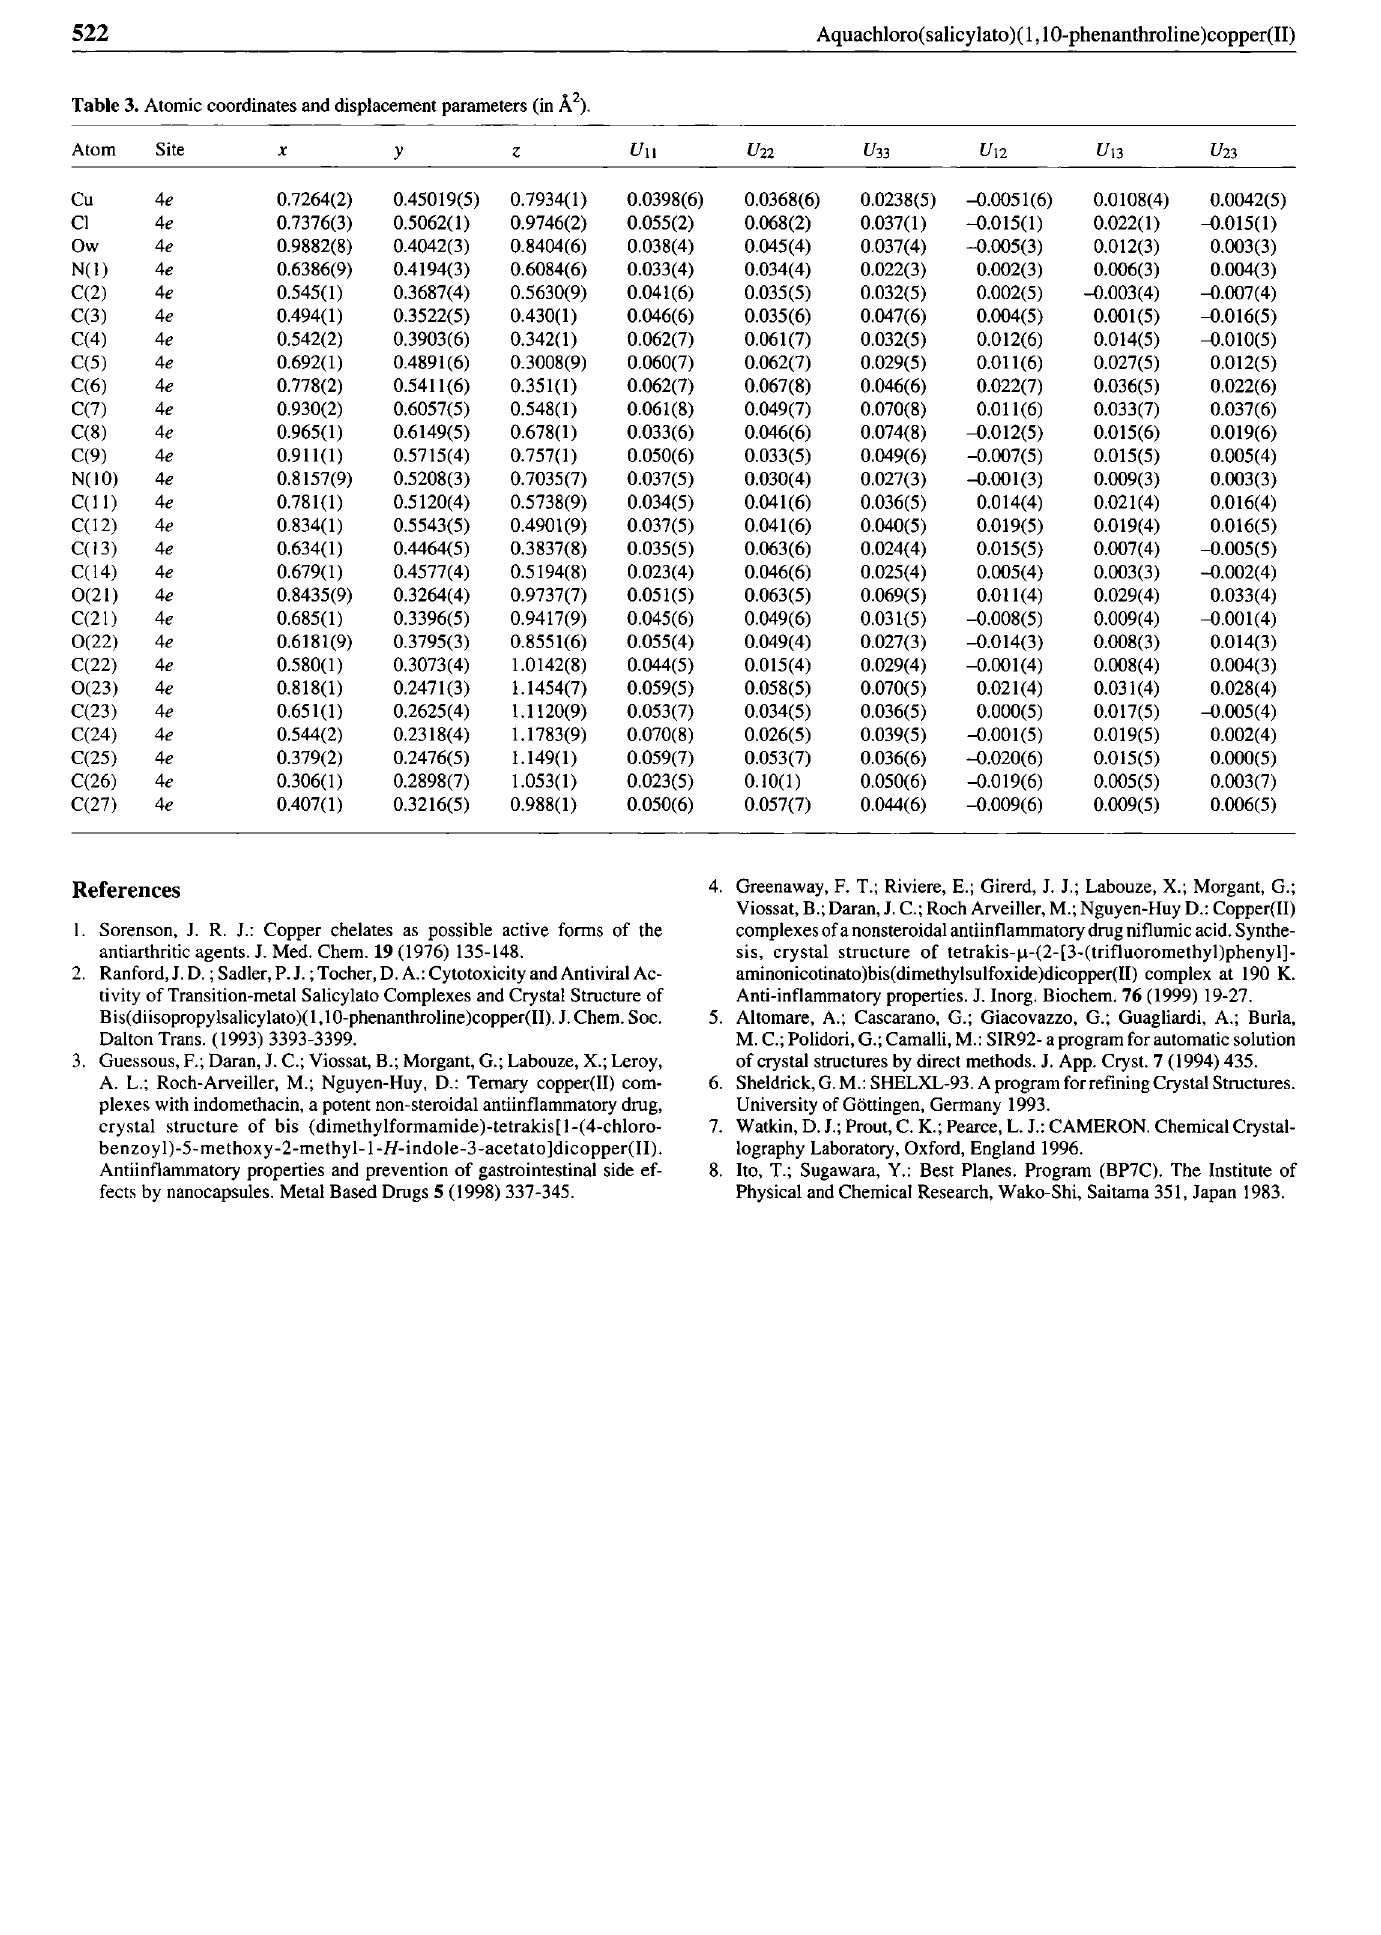
Table 3. Atomic coordinates and displacement parameters (in Â 2